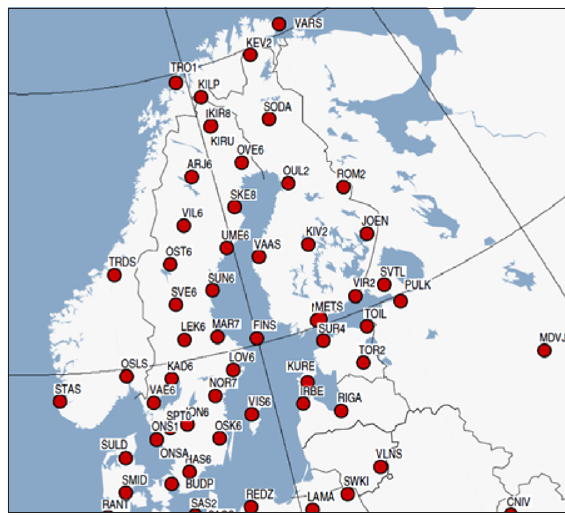
Figure 3. EPN stations in northern Europe (EPN, 2018 modif)